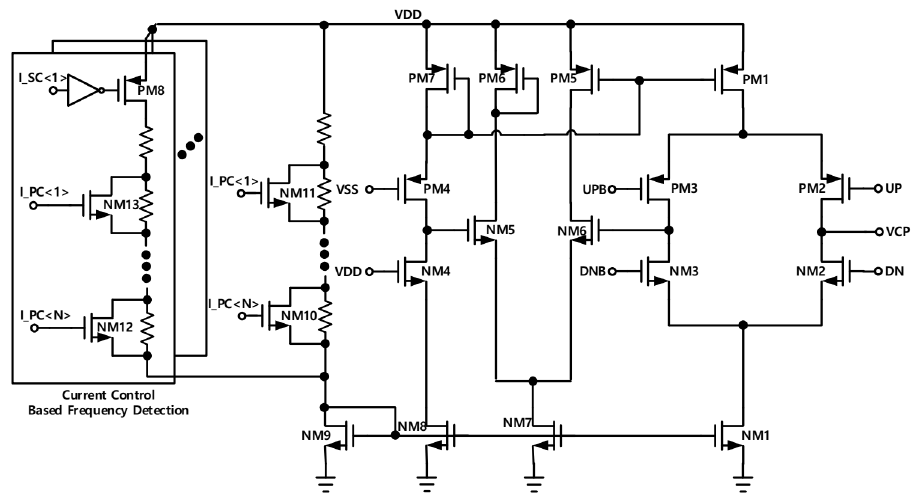
Figure 6. Schematic of the proposed bias-controlled CP.